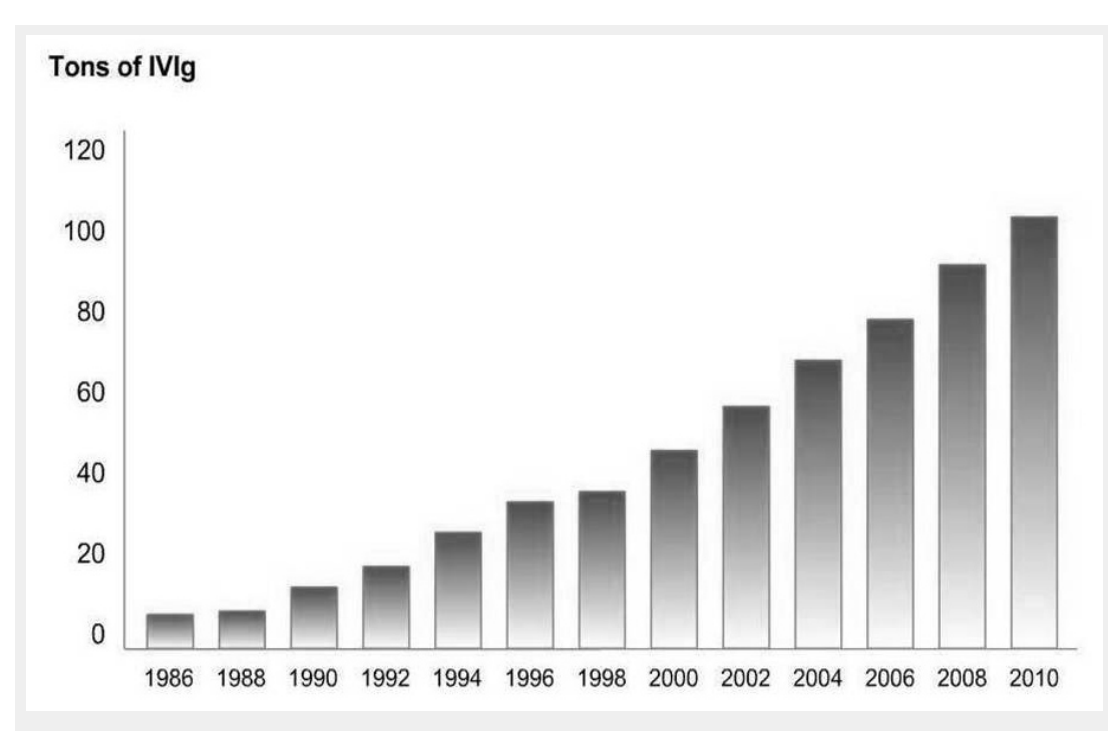
Figure 4 Total world consumption of IVIG: currently the IVIG production exceed 100 tonnes per year (published in International Blood/Plasma News (ibpn), ©The Marketing Research Bureau Inc., Orange CT 40677 (mrb_ibpn@earthlink.net). Reprinted with kind